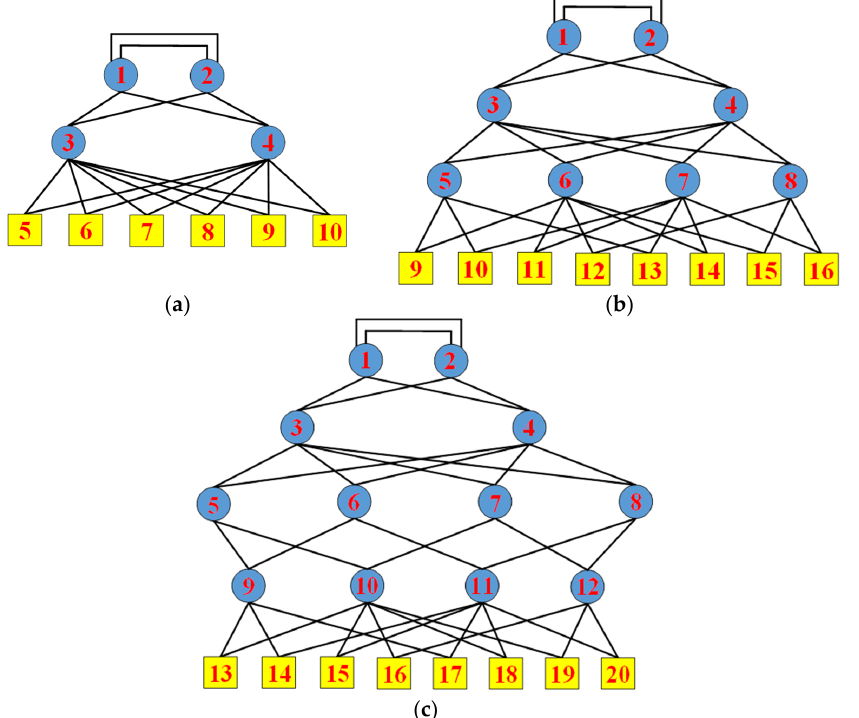
Figure 3. Redundancy topology diagram with ( a ) 10 nodes; ( b ) 16 nodes; and ( c ) 20 nodes.